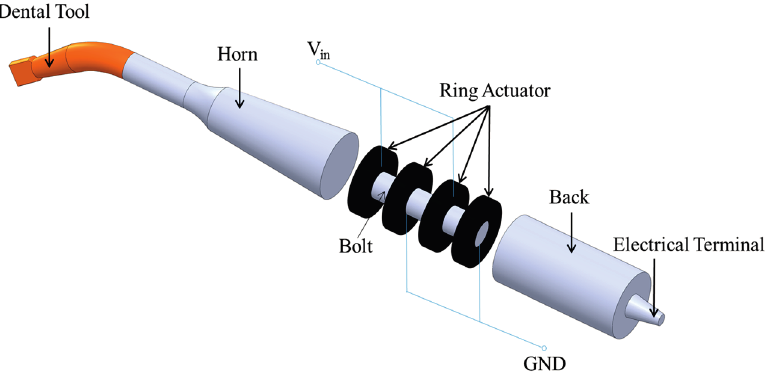
Figure 1. Composition of the ultrasonic dental handpiece.